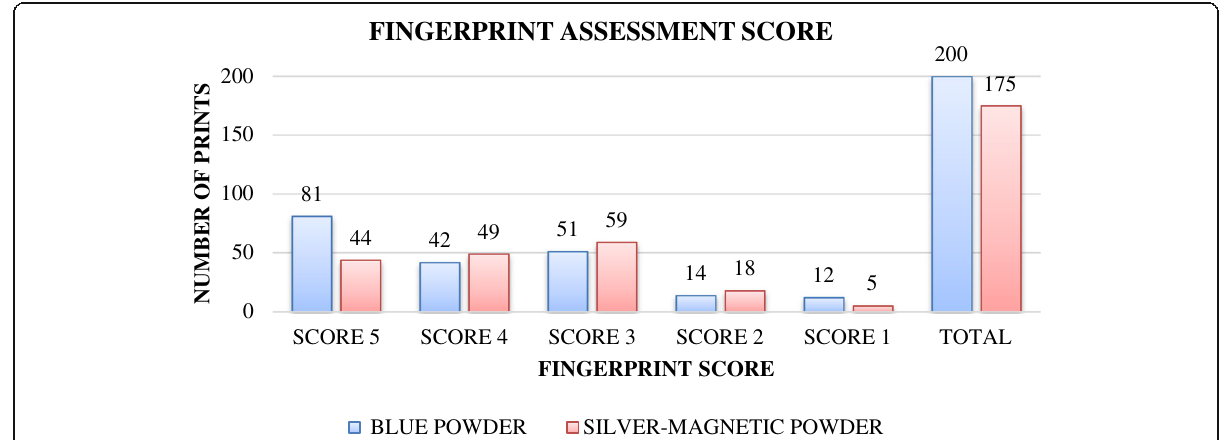
Fig. 1 Fingerprint assessment score in the succession prints developed using both the powders